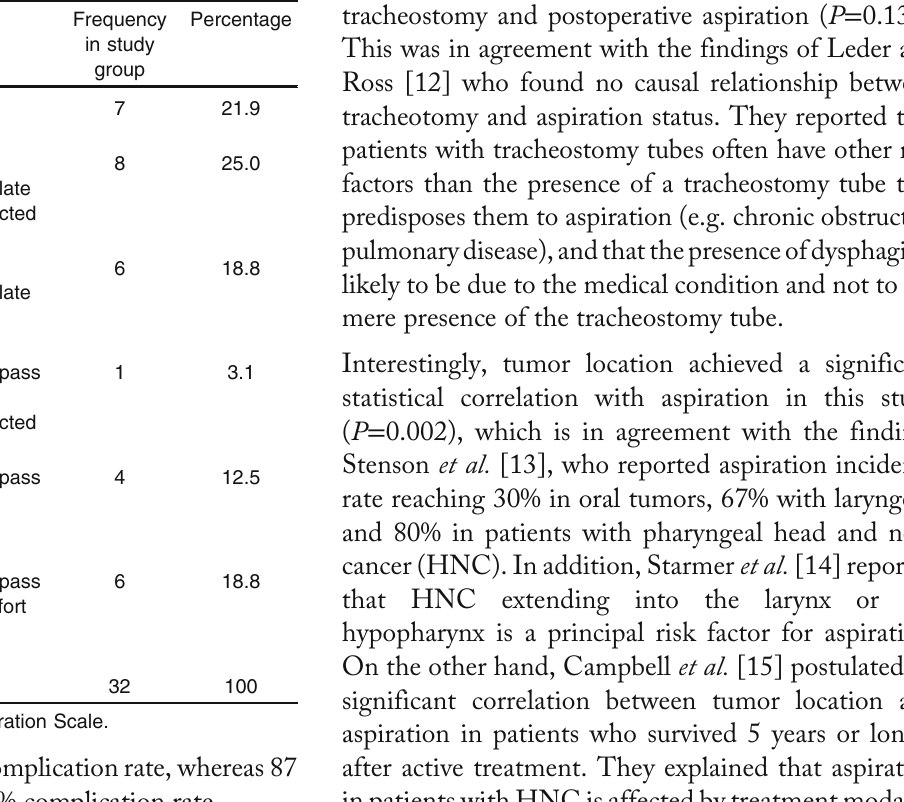
Table 6 Results of MPAS in the study